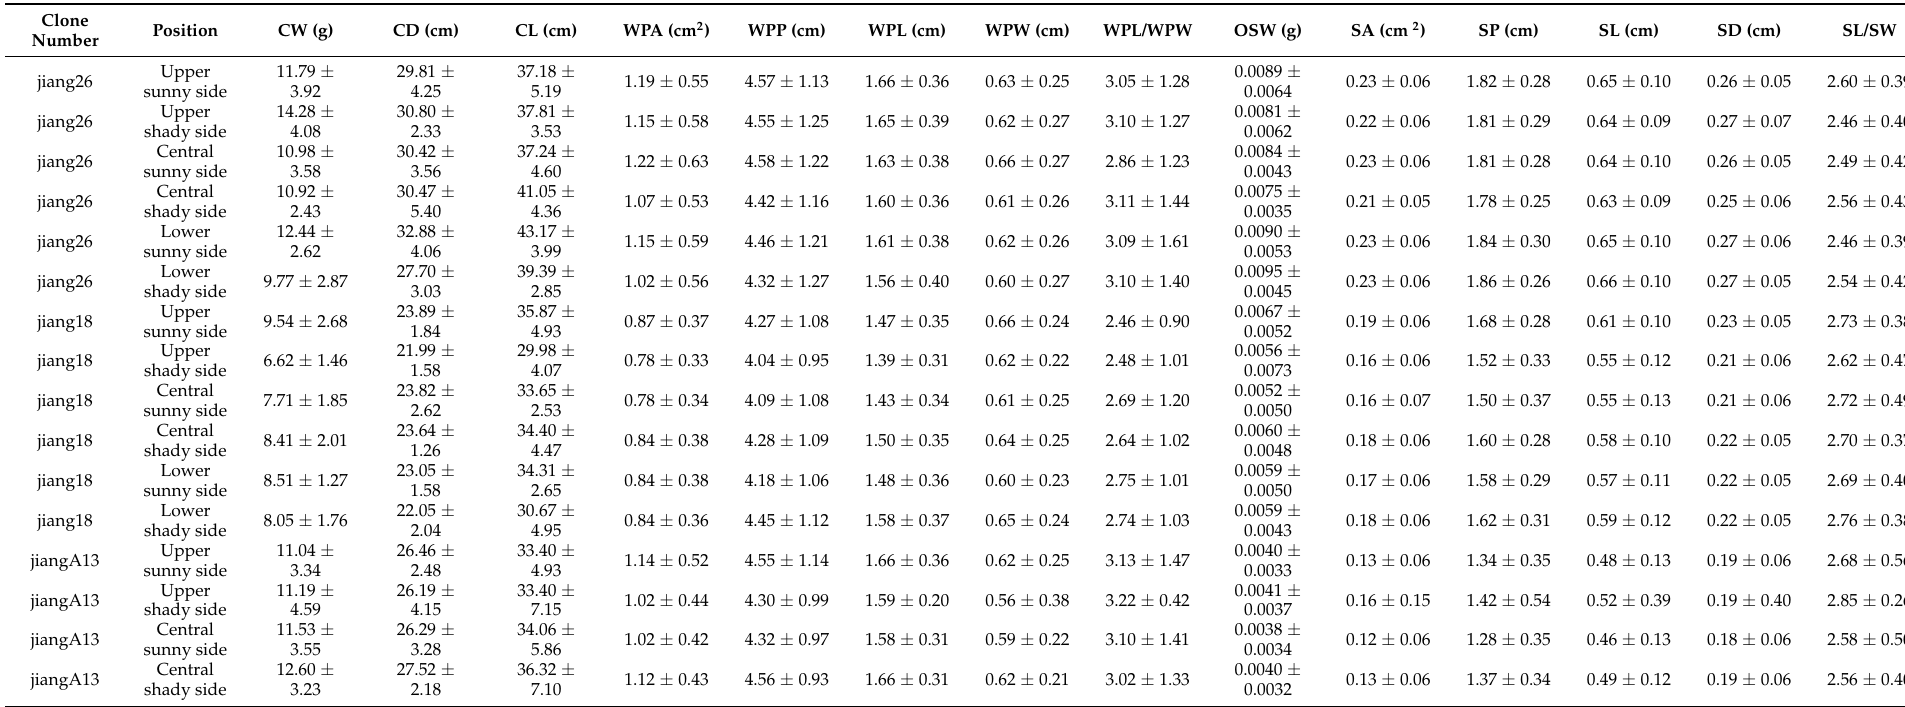
Table 5. Average values of phenotypic characters of bract scales and seeds from different crown layers of the three Chinese fir